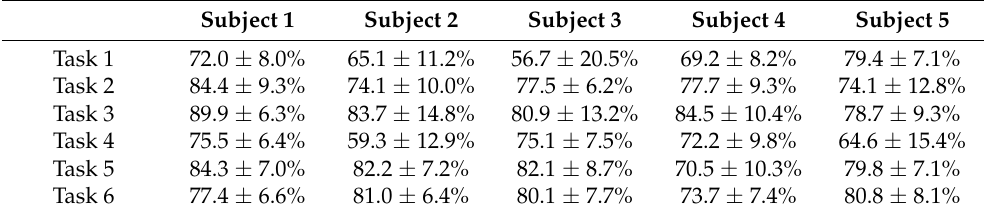
Table 2. Correlations between the neural decoded kinematics and recorded kinematics (Mean ±